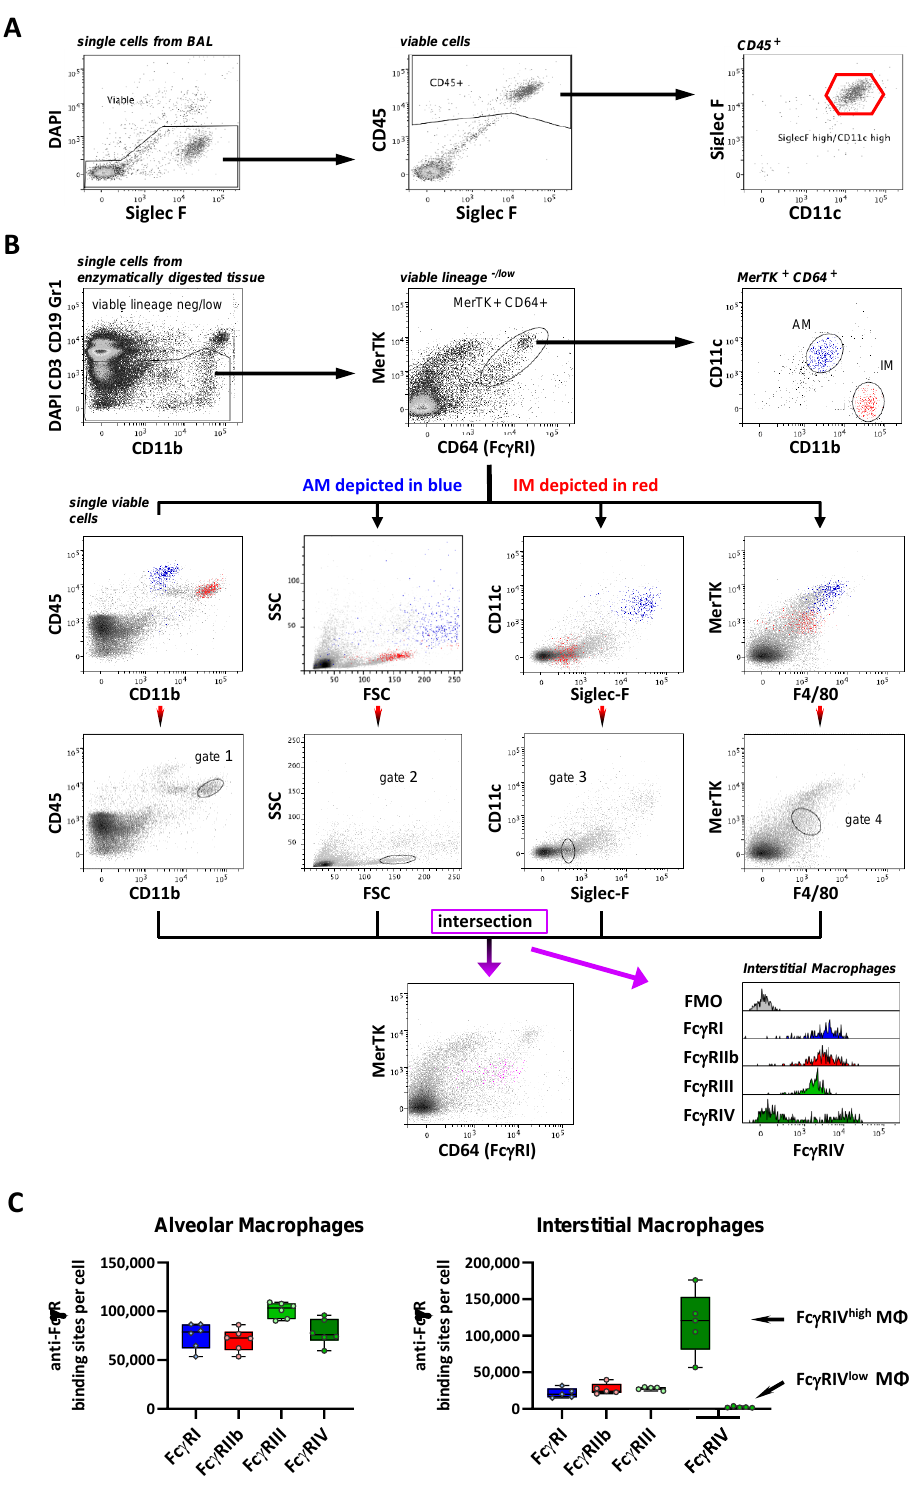
Figure 3. Characterization of the FcγR expression on pulmonary macrophages. ( A ) Depicted are single cells from the bronchoalveolar lavage (BAL). By selecting DAPI-negative cells, dead cell exclusion was performed. Next, the viable cells were subdivided based on their expression of CD45, Siglec F and CD11c. Among the CD45-positive populations, alveolar macrophages were identified by a pronounced expression of both Siglec F and CD11c. ( B ) Single cells from enzymatically digested lung tissue were stained with DAPI and antibodies specific for B-cell (CD19) and T-cell (CD3) markers, as well as Gr-1 (Ly6G and Ly6C) in a dump channel. Viable and CD19/CD3-negative cells and CD11b-positive Gr-1-negative-to-